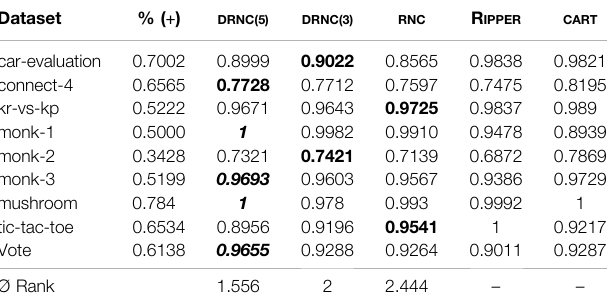
TABLE 3 | Accuracies on real-world datasets. Rule network with 1/3/5 layers vs R IPPER vs CART. Thebest accuracy oftherule networks ismarked in bold,the overall best accuracy per dataset is marked in